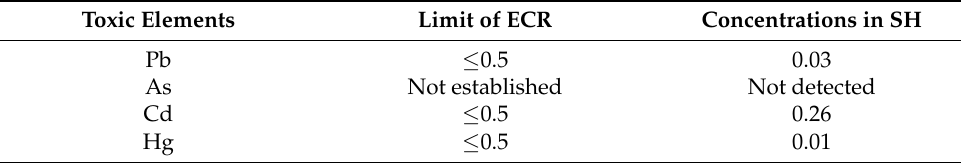
Table 1. The concentrations of Pb, As, Cd, and Hg in SH (dry basis, mg/kg).